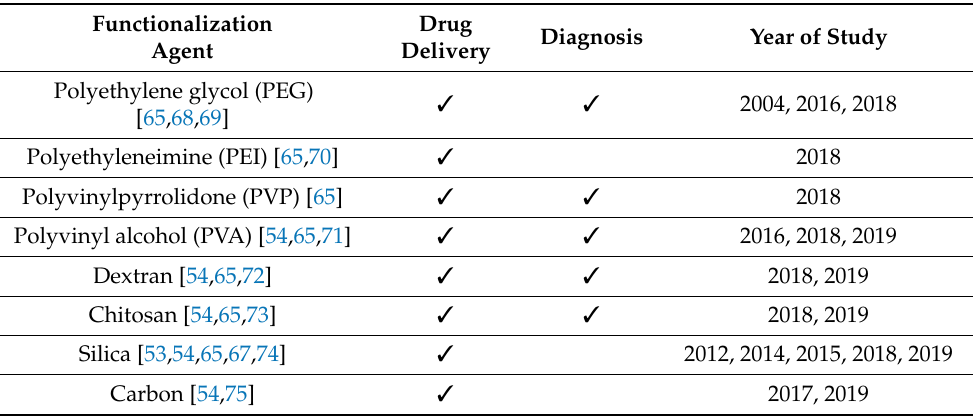
Table 2. Several functionalization agents used on MNPs for drug delivery and diagnosis. The check mark represents the biomedical application it is used for. Functionalization